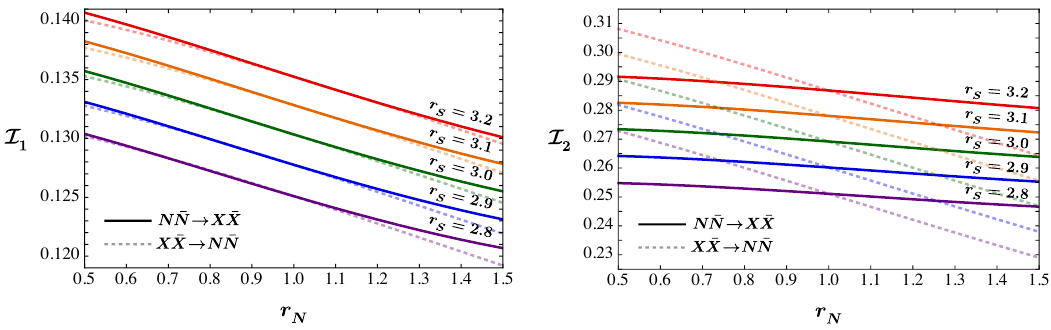
with different choices of r N